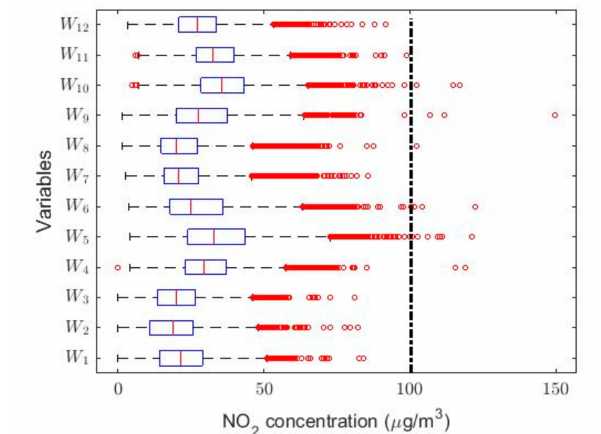
Figure 7. Box plot of data: W 1 (0:00–1:00), W 2 (2:00–3:00), W 3 (4:00–5:00), W 4 (6:00–7:00), W 5 (8:00–9:00), W 6 (10:00–11:00), W 7 (12:00–13:00), W 8 (14:00–15:00), W 9 (16:00–17:00), W 10 (18:00–19:00),